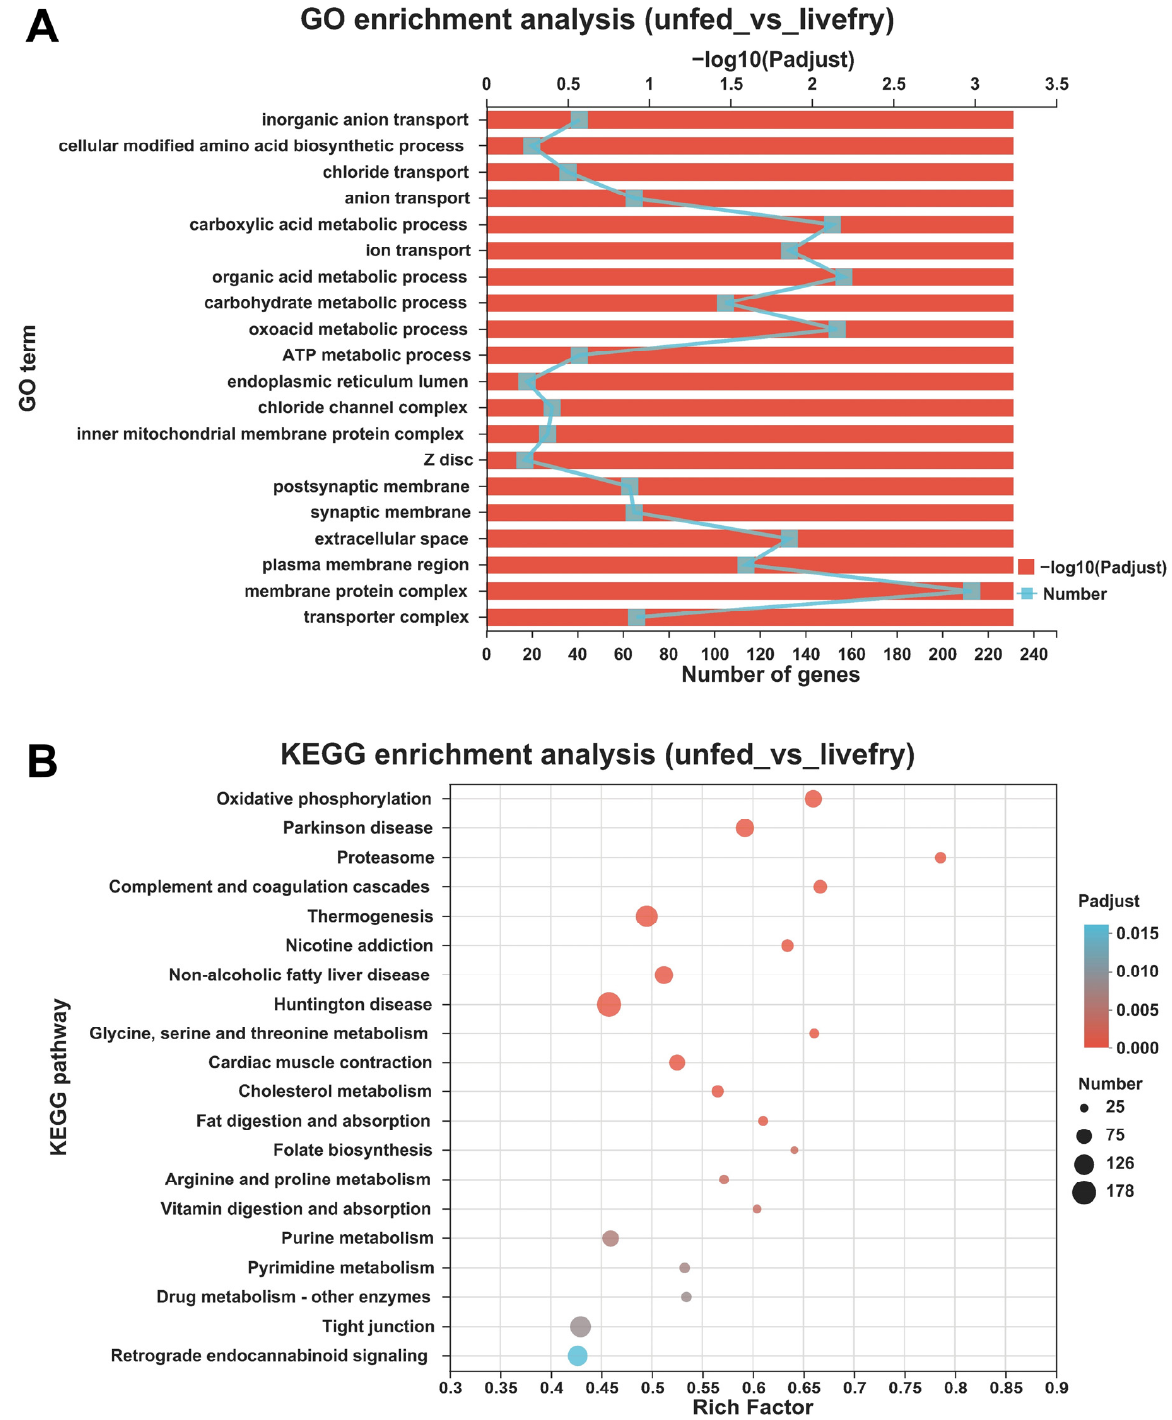
Figure 3. Functional enrichment analyses of DEGs between the mandarin fish larvae unfed and fed with live prey fish. ( A ). Top 20 GO enrichment terms; ( B ). Top 20 KEGG enrichment